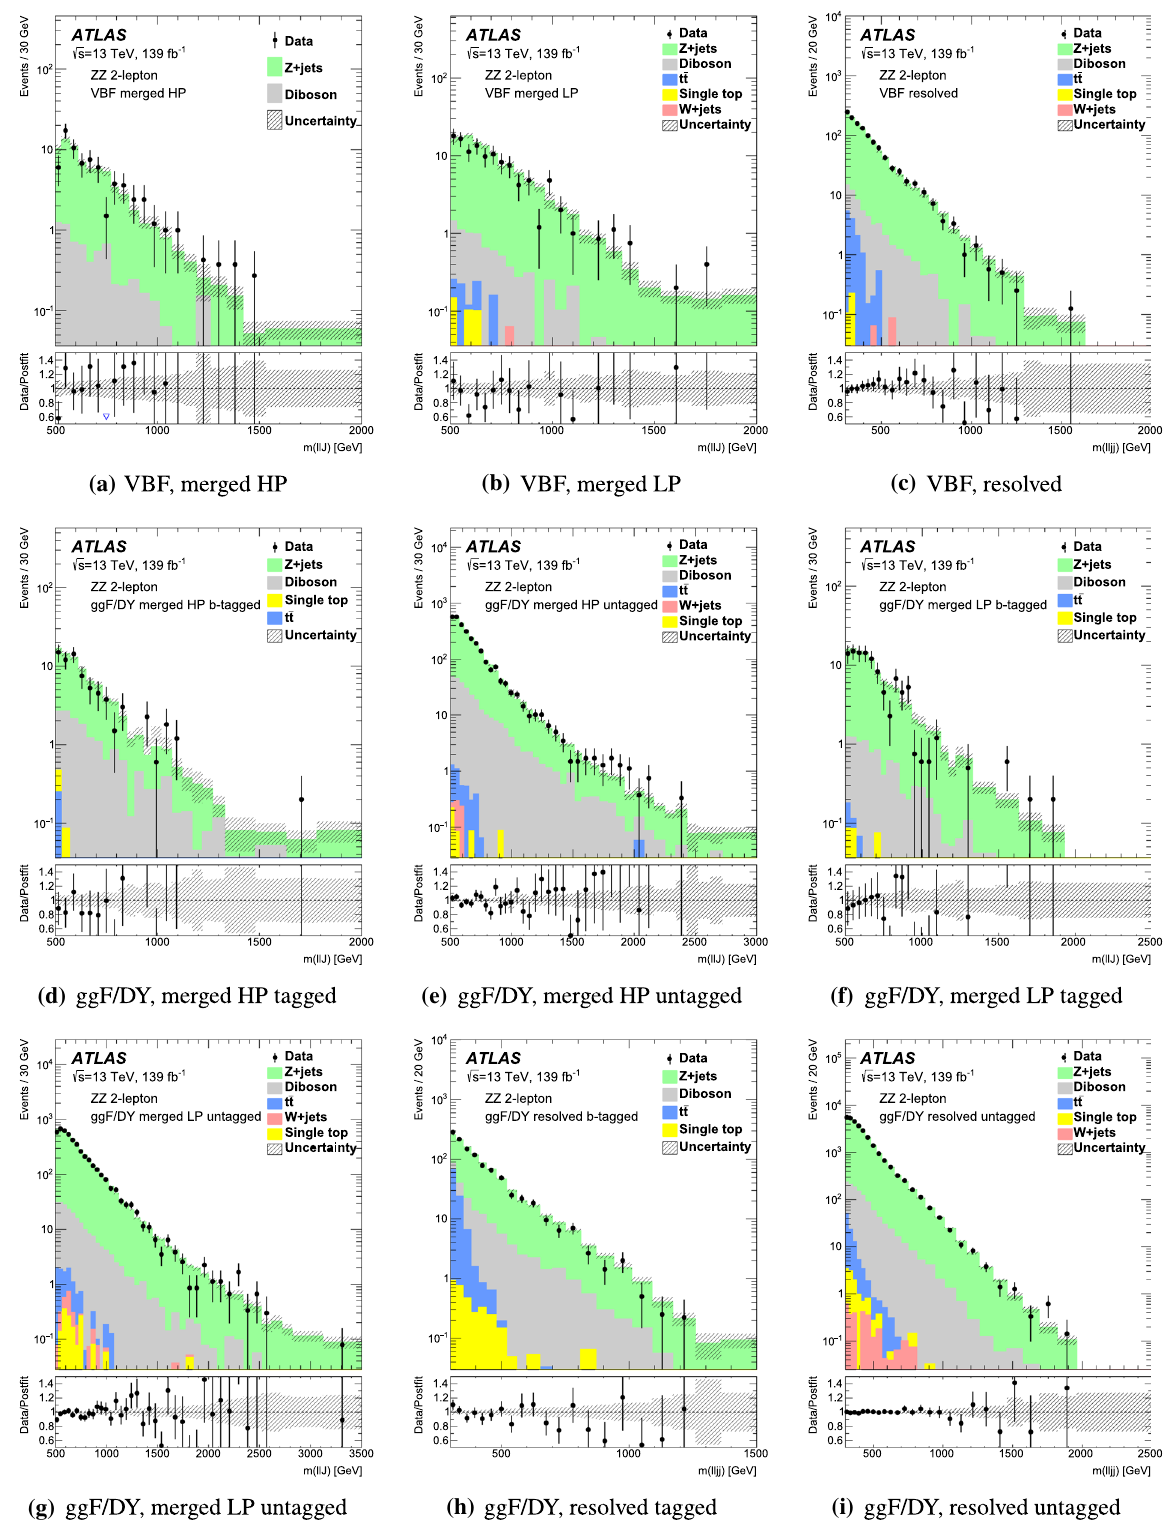
Fig. 11 Comparisons of the observed data and the expected back- ground distributions of m (cid:4)(cid:4) jj or m (cid:4)(cid:4) J in the 9 Z Z SRs of the 2- lepton channel. The background predictions are obtained through a background-only simultaneous fit to the 6 WW and 15 Z Z SRs and their respective V + jets and t ¯ t CRs (see text). The bottom panes show